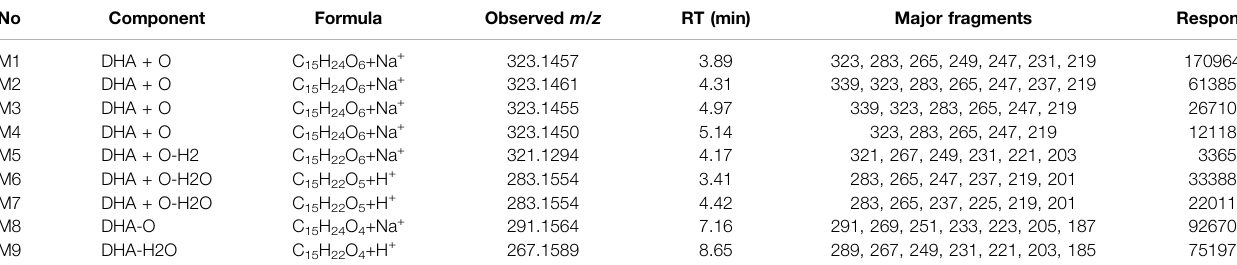
TABLE 1 | Summary of microbial transformation products of dihydroartemisinin.